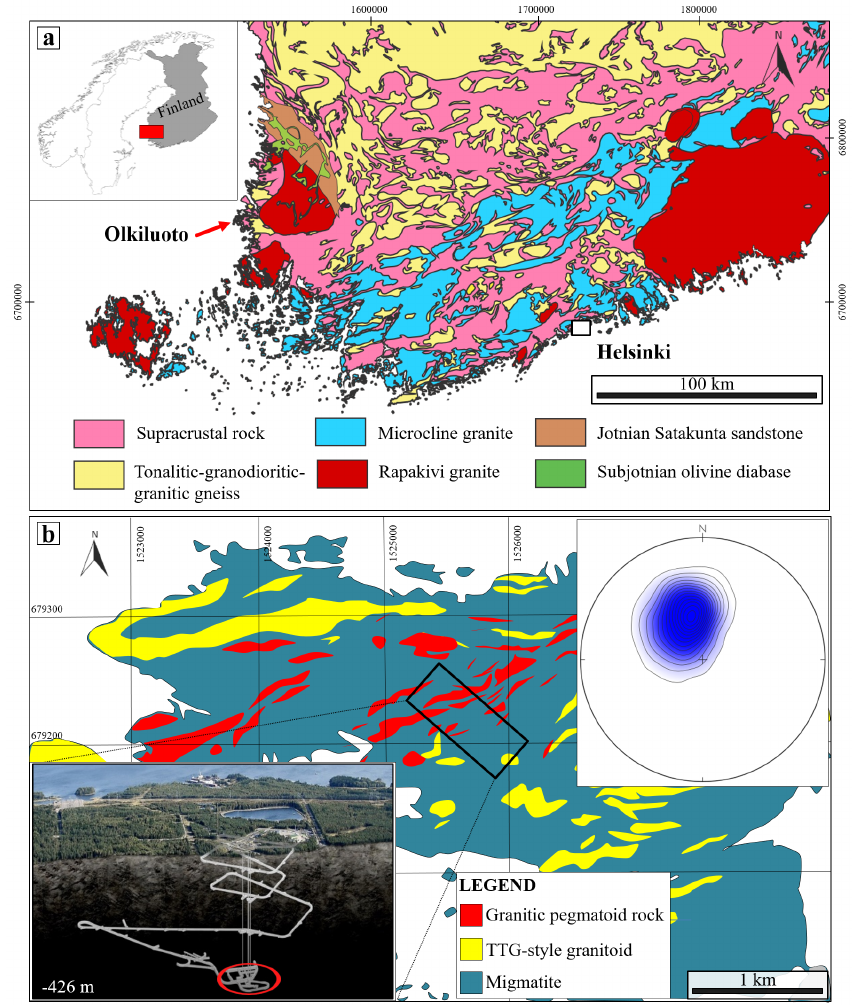
Figure 1. (a) Simplified geological map of southwestern Finland modified after Mattila and Viola (2014). (b) Geological sketch of Olkiluoto Island. The upper right inset shows the poles to foliation planes measured from all available Olkiluoto drill cores ( N = 4479, equal area, lower hemisphere projection; Mattila and Viola, 2014). The lower left inset is a panoramic photograph with an overlay drawing of the underground infrastructure (photo courtesy of Posiva Oy, Finland). The red circle shows the depth location of BFZ300. Coordinates are given in the local KKJ1 coordinate